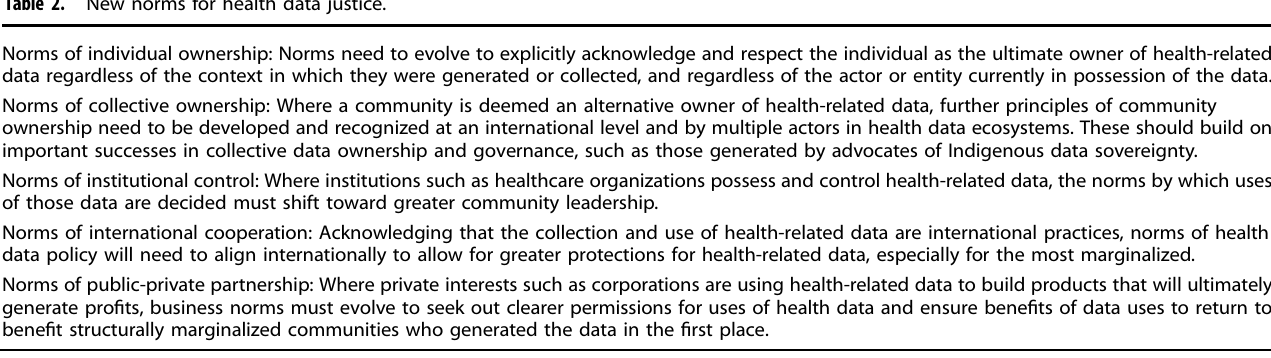
Table 2. New norms for health data